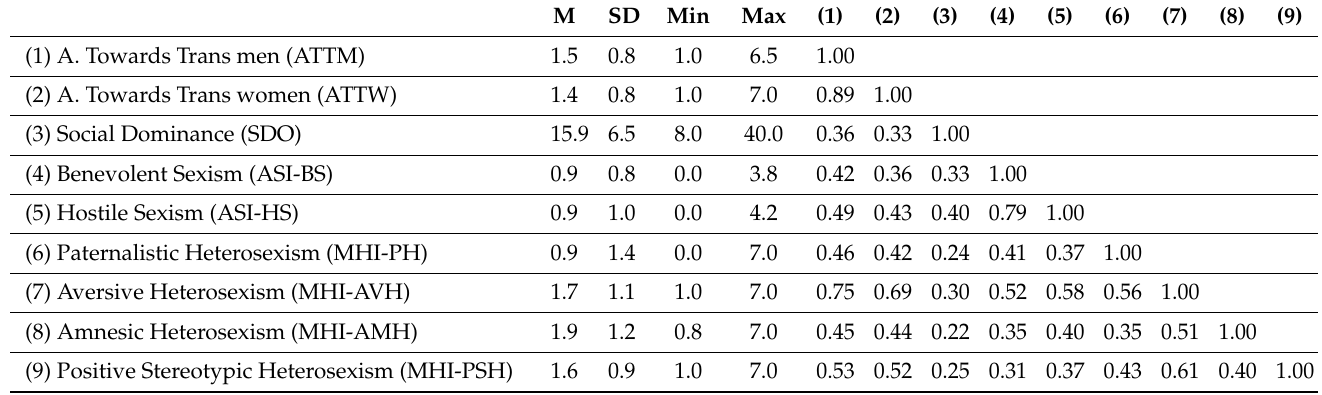
Table 4. Descriptive Statistics and Correlation between ATTM and ATTW and External Variables.